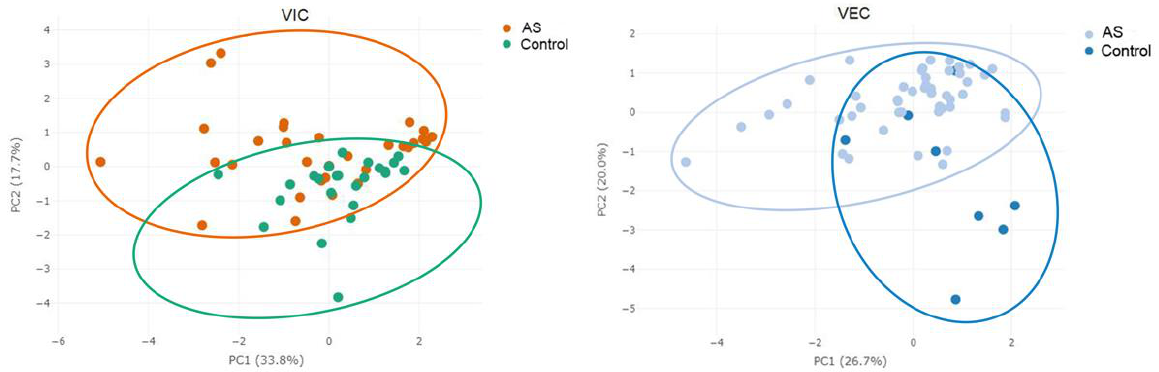
Figure 5. Principal component analysis (PCA) plot representing ENTPD1, ENPP1, ADA, NT5E, P2RX1, P2RX7 and ADORA2b gene expression in non-stenotic (Control) and stenotic (AS) VICs and VECs.